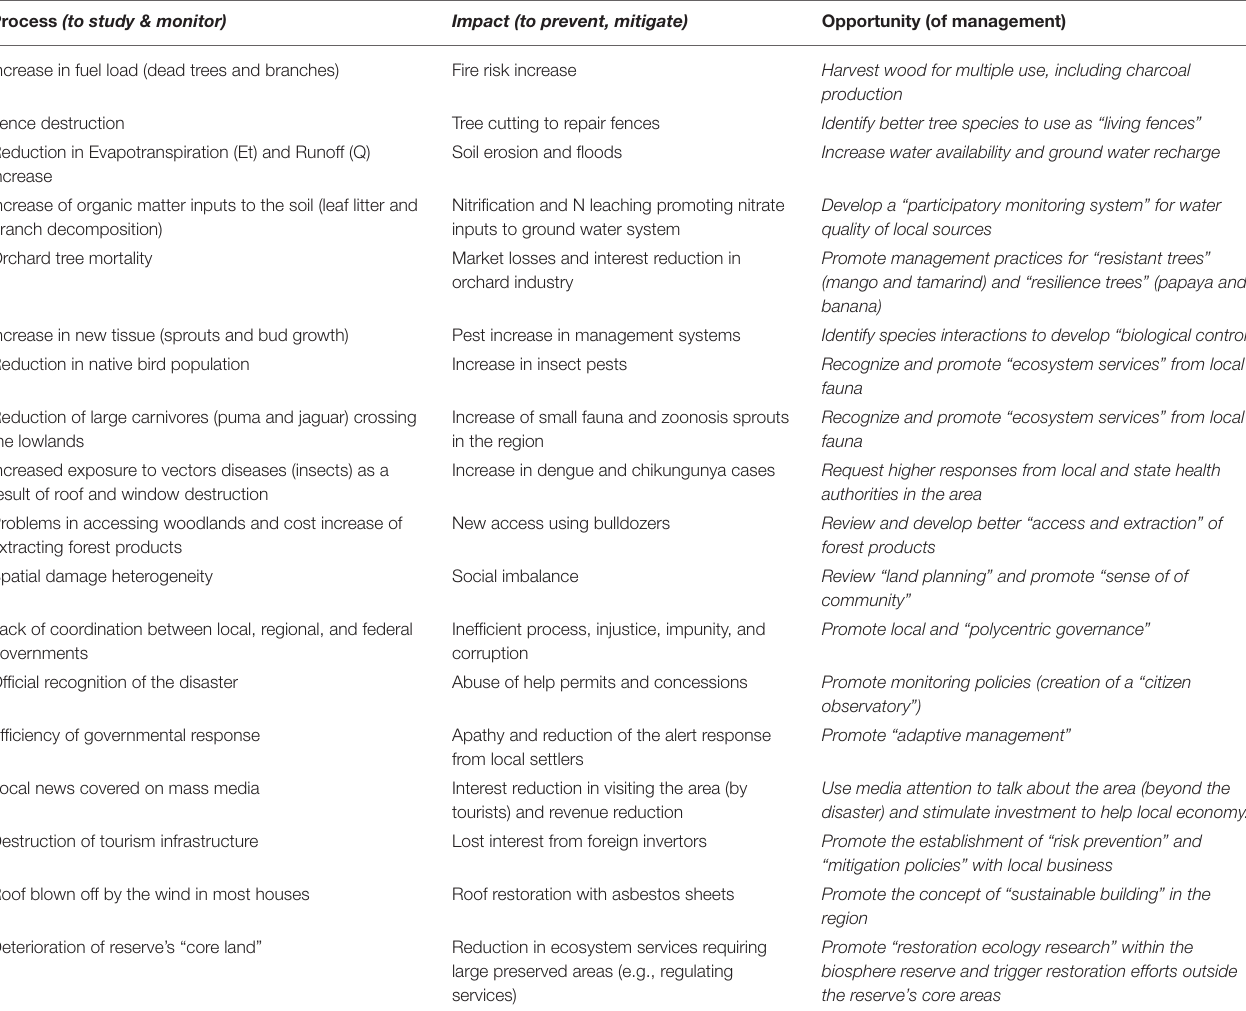
TABLE 1 | Processes, impacts, and management opportunities as a result of Hurricane Patricia affecting the tropical dry-deciduous forest at the Chamela-Cuixmala Biosphere Reserve. Process (to study &